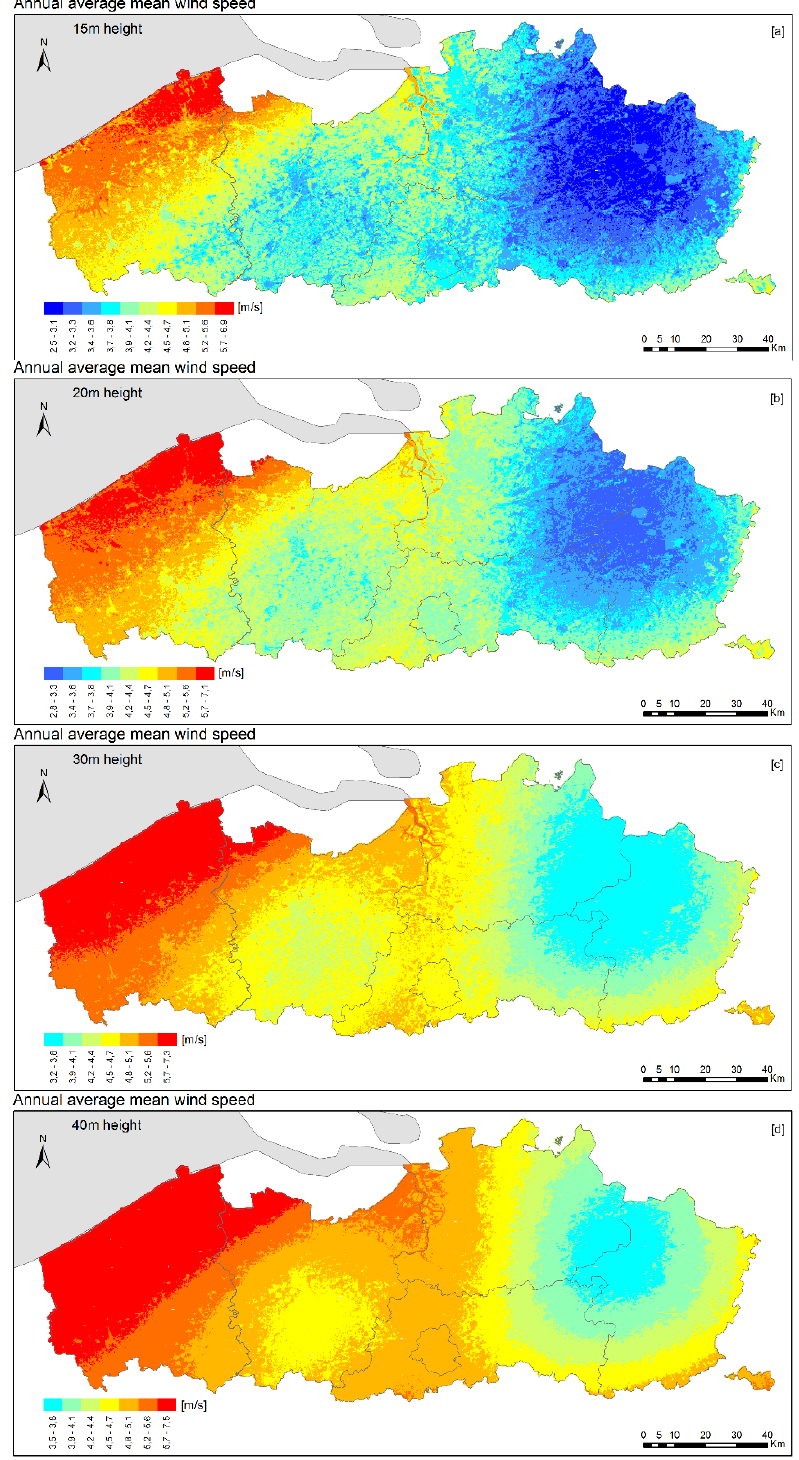
Figure 6. Annual mean wind speed, ( a ) 15 m, ( b ) 20 m, ( c ) 30 m, ( d ) 40